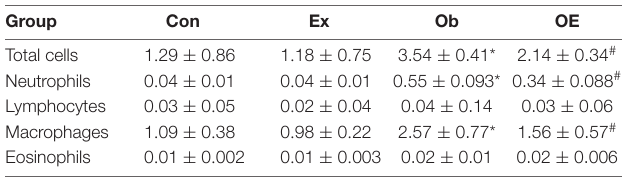
Detection of Pulmonary Fibrosis Masson staining showed the degree of pulmonary